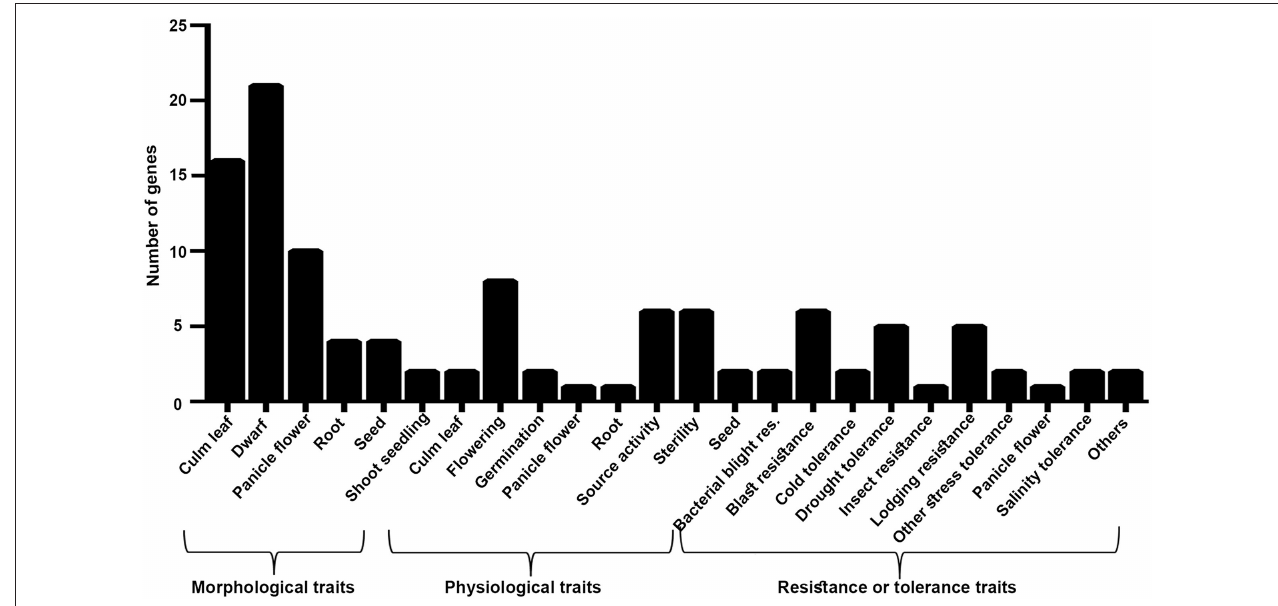
FIGURE 7 | Morphological, physiological, and resistance- or tolerance-related traits associated with 62 NUE-candidate